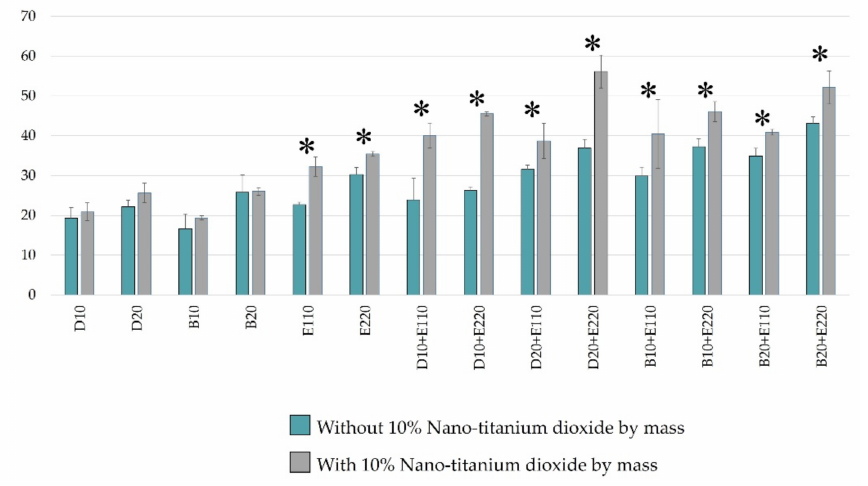
Figure 3. Comparison of ROS between test photosensitizers with and without 10% nano-titanium dioxide by mass using ESR ( n = 3). Green column = without 10% nano-titanium dioxide and grey column = with 10% nano-titanium dioxide. * = significant difference at ( p < 0.05) between groups with the same component.